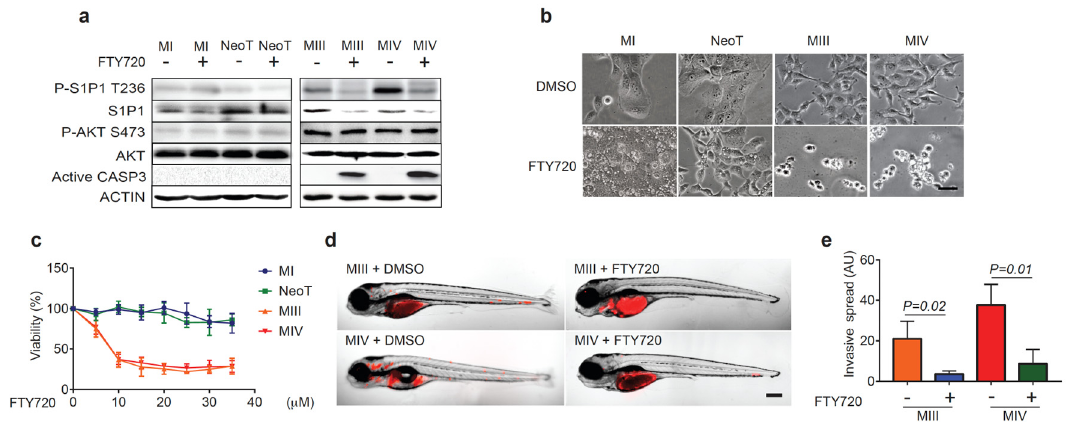
Figure 6. FTY720 induces apoptosis and suppresses the distant spread of human TNBC cells with high P-S1P1 T236 Levels. ( a ) Western blot analysis of P-S1P1 T236, S1P1, P-AKT S473, AKT, active CASPASE 3 (CASP3), and ACTIN levels in MI, NeoT, MIII, and MIV cells before and after FTY720 treatment (2 µ M). ( b ) Brightfield images of MI, NeoT, MIII, and MIV cells at 48 h post-treatment with DMSO or FTY720 ( n = 3 per group). The scale bar represents 1 µ M. ( c ) The proportion of viable cells in response to a dose gradient of FTY720 shows a significantly reduced viability of MIII and MIV though not MI nor NeoT cells ( n = 3 per group). ( d ) Overlay of brightfield and fluorescence images of zebrafish embryos injected with RFP + MIII and MIV cells treated with DMSO or FTY720 (2 µ M) at 3 dpt ( n = 3 per group). The scale bar represents 200 µ m. ( e ) Quantification of fluorescent intensity of tumor cells described in ( d ) Shows FTY720 (cid:48) s ability to inhibit the distant spread of TNBC cells ( n = 3 per group). Data indicate mean ± SEM.